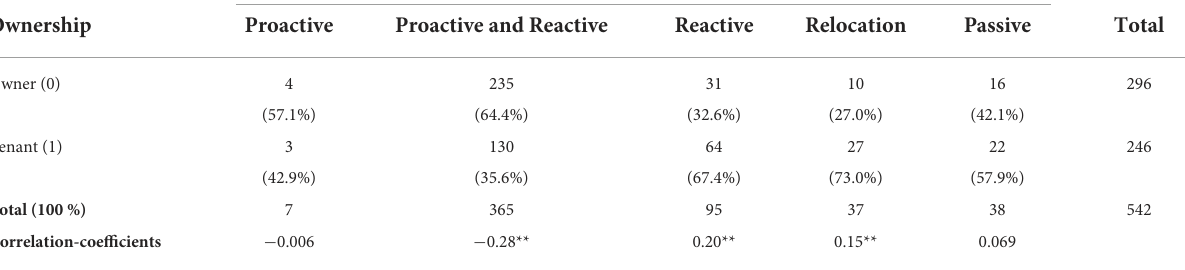
TABLE 9 Contingency table for ownership of the building and the chosen adaptation strategy of the businesses with phi correlation coefficients ( n = 101, data: businesses in Germany damaged by pluvial floods 2014-2017).